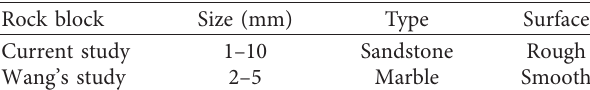
Figure 11: Rock blocks comparison: (a) this study; (b) Wang’s study. Table 1: Comparison of rock block